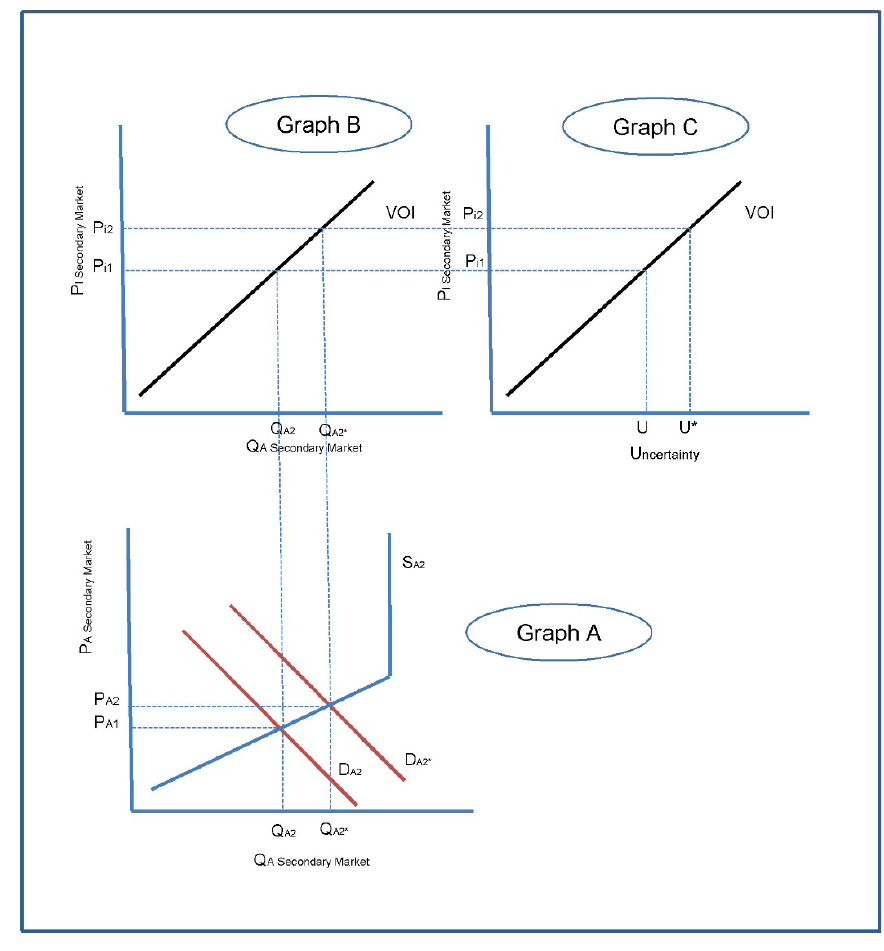
FIGURE 2: Uncertainty and the price of information. Source: Authors’